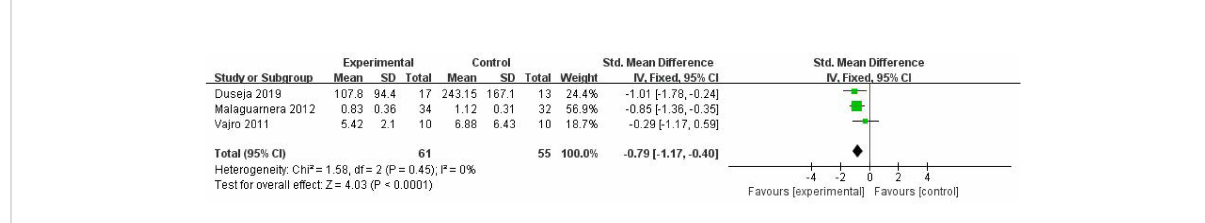
FIGURE 8 Forest plot of the effect of probiotic supplementation on TNF- a in the included studies with baseline BMIs of less 28 kg/m2.